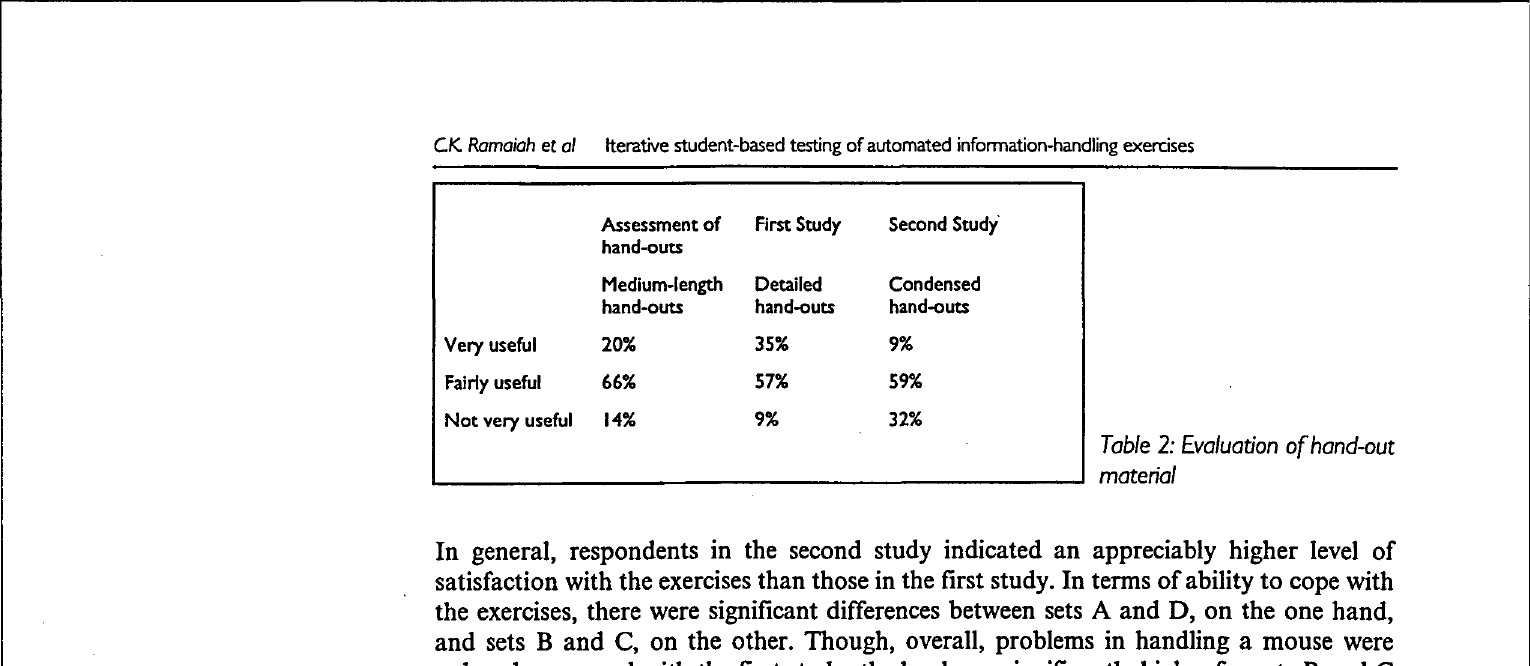
Table 2: Evaluation of band-out